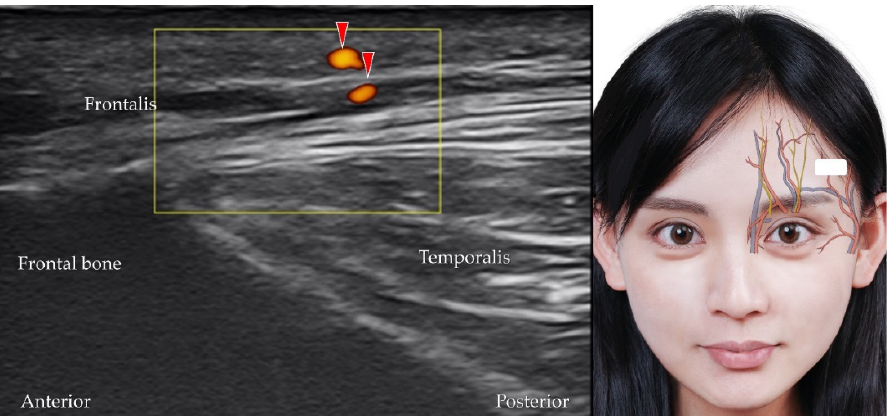
Figure 8. Power Doppler ultrasound imaging of the frontal branch of the superficial temporal artery (red arrowheads) and its branches. White square , footprint of the ultrasound transducer.